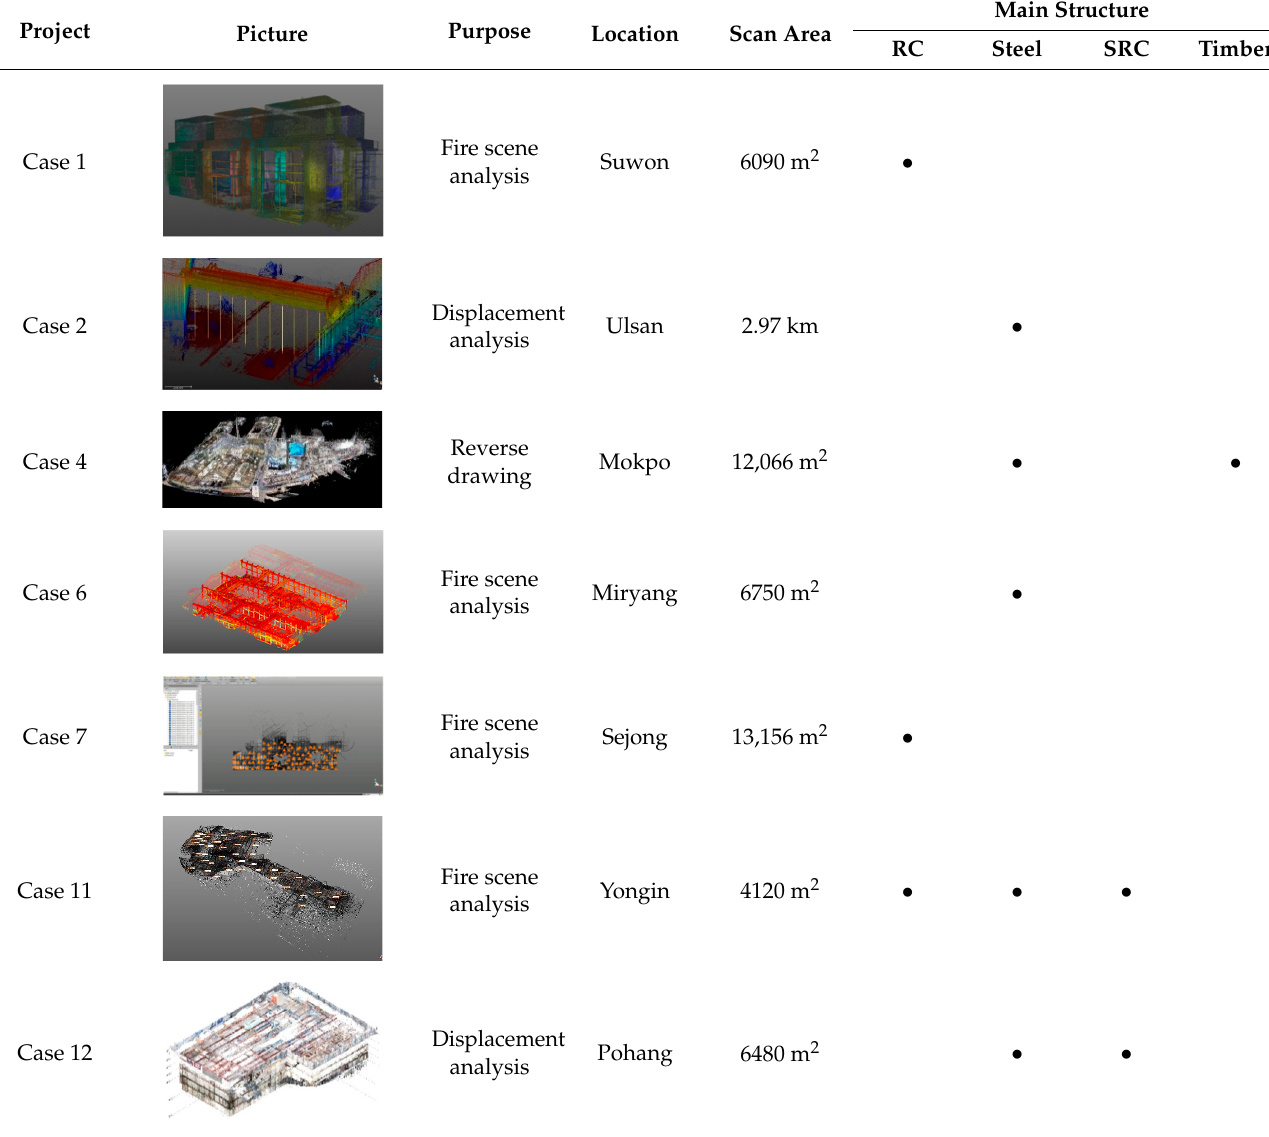
Table 2. Scan-vs-BIM cases.